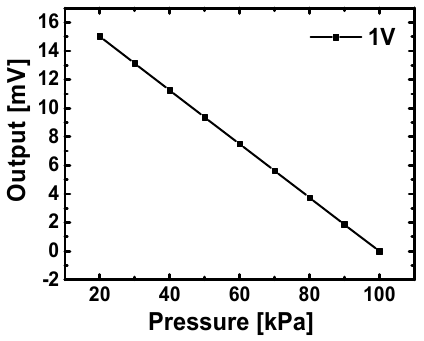
Figure 5. Simulated results of a pressure sensing element at 1 V input supply.